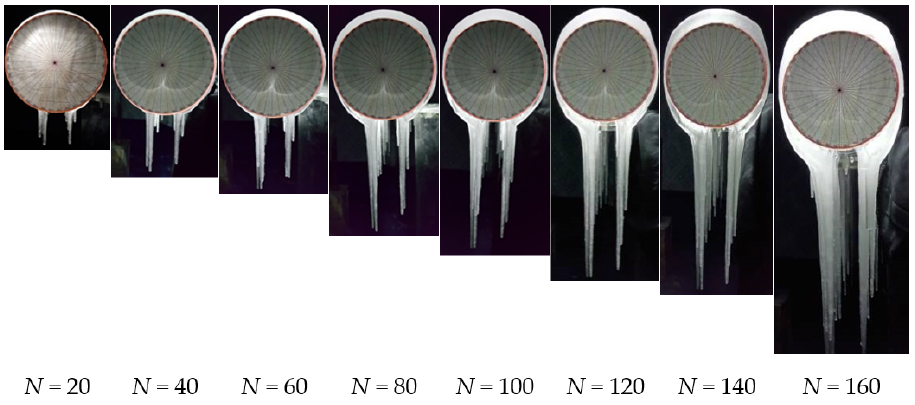
Figure 10. Profiles of ice accretions for various N ( D = 150 mm).